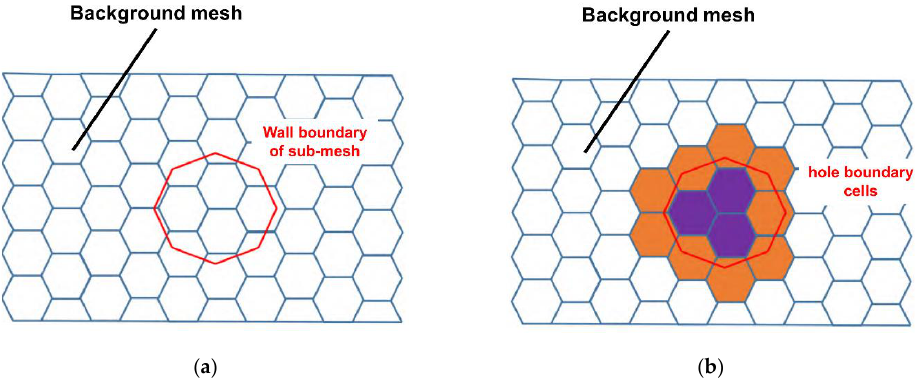
Figure 5. Schematic diagram of the overset assembly based on the “direct cutting” strategy: ( a ) two overset sub-meshes; ( b ) direct cutting technique.